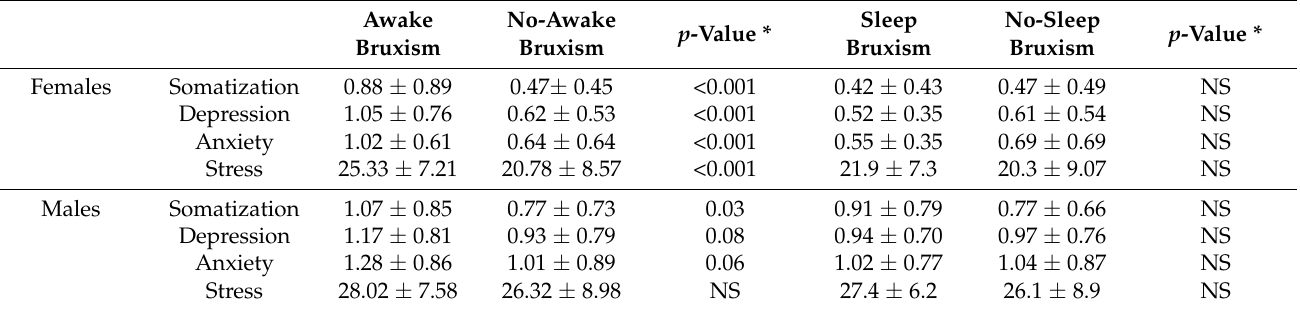
Figure 2. Prevalence of ( a ) AB and ( b ) SB in males and females according to the stage of education (* p < 0.05, ** p < 0.001). Emotional parameters (Somatization, Depression, Anxiety, and Stress) were signifi- cantly higher in students reporting AB, mostly in females (Table 1). Males, however, showed a tendency for the same pattern, yet a statistically significant difference was only noted for the Somatization parameter. Table 1. Emotional parameters (Somatization, Depression, Anxiety, and Stress) were identified in male and female students either reporting AB/SB or not (student t -test).